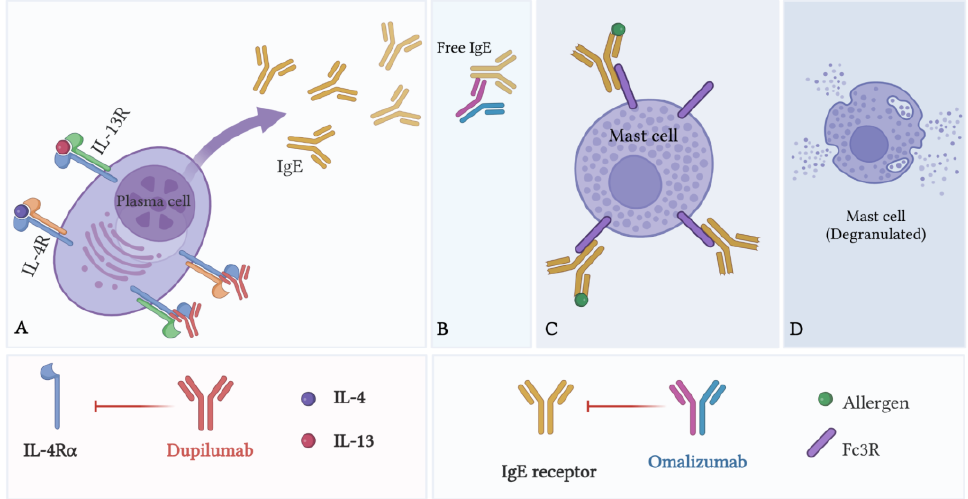
Figure 2. Dupilumab and omalizumab modulate MC activation. Dupilumab is a fully human monoclonal antibody that binds IL-4R α . It blocks IL-4 and IL-13 signaling, thus inhibiting IgE production ( A ). Omalizumab is a humanized monoclonal antibody that binds free IgE in the blood ( B ), preventing IgE from binding to MC-bound Fc3R ( C ), thus inhibiting IgE-dependent MC activation ( D ). Figure 2 created using BioRender.com).